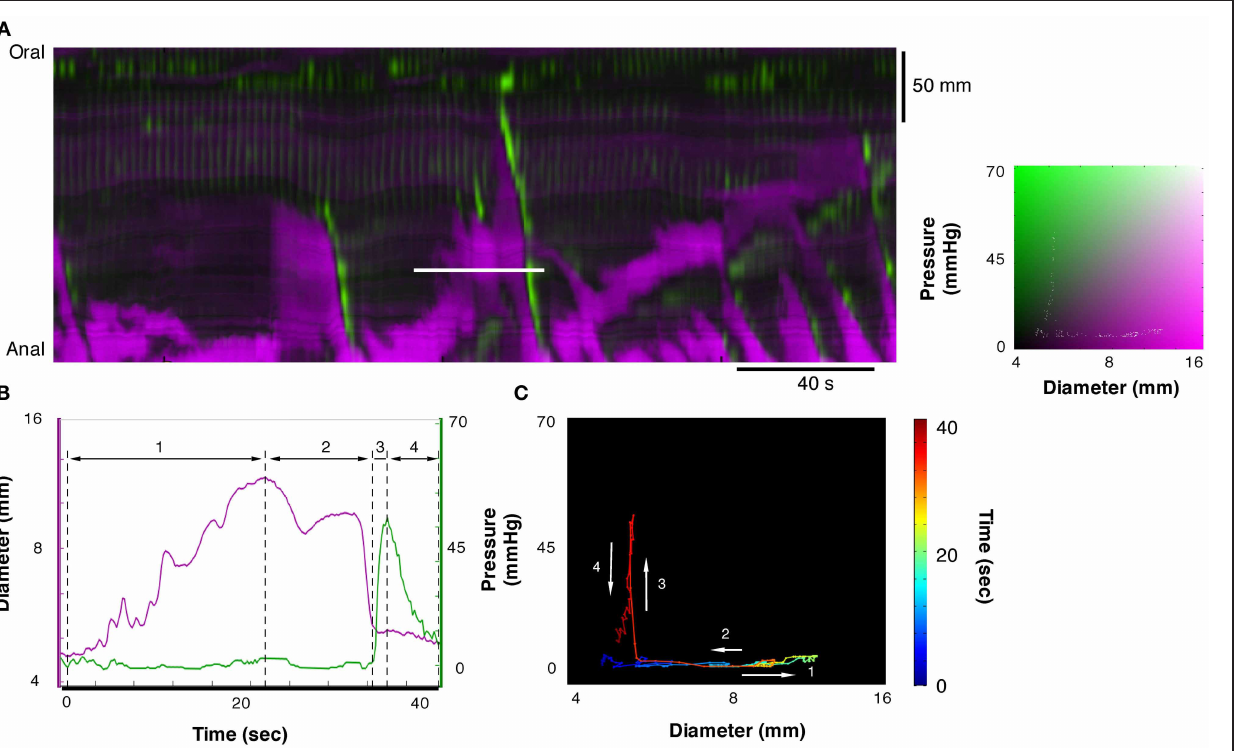
FIGURE 5 | Example of orbit plot taken from the DPMap (A). The pressure and diameter line traces in (B) and the orbit in (C) are constructed from the white line in (A) . In this example the orbit consists of 4 segments. The first, blue to green section shows an isotonic relaxation (segment 1 in B ; see also blue arrow in Figure 3C ). The second segment, pale green to red, represents an isotonic contraction , where the